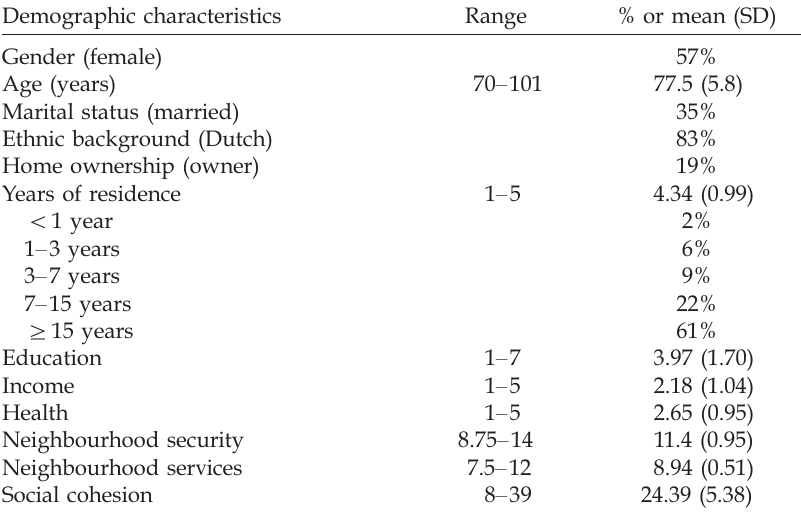
Table 1. Descripti v e